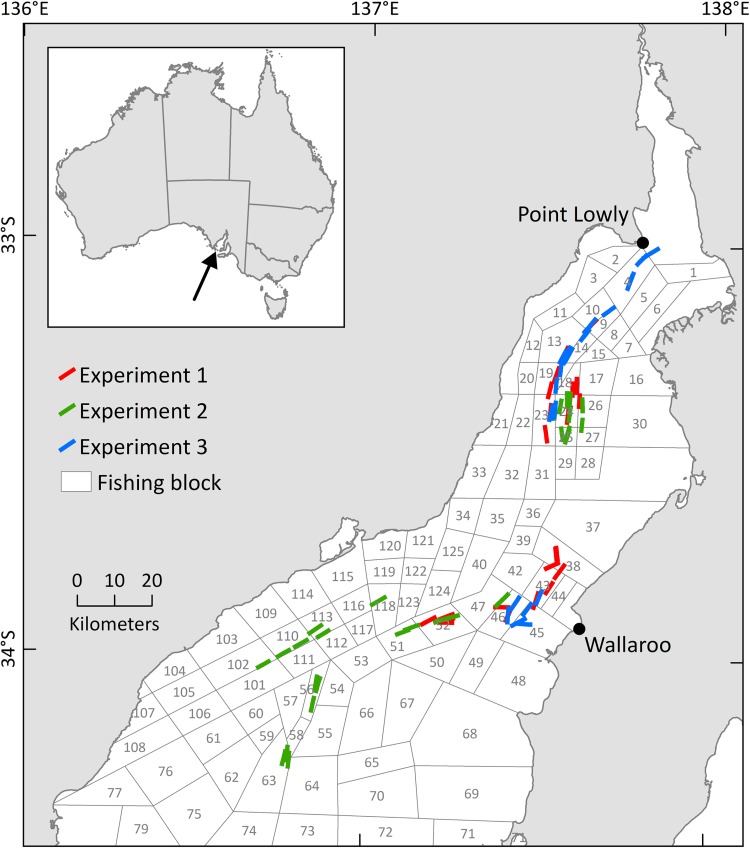
Map of northern Spencer Gulf showing the trawl paths of the study.Also shown are commercial fishing blocks (polygons). Inset map shows study location in Australia.